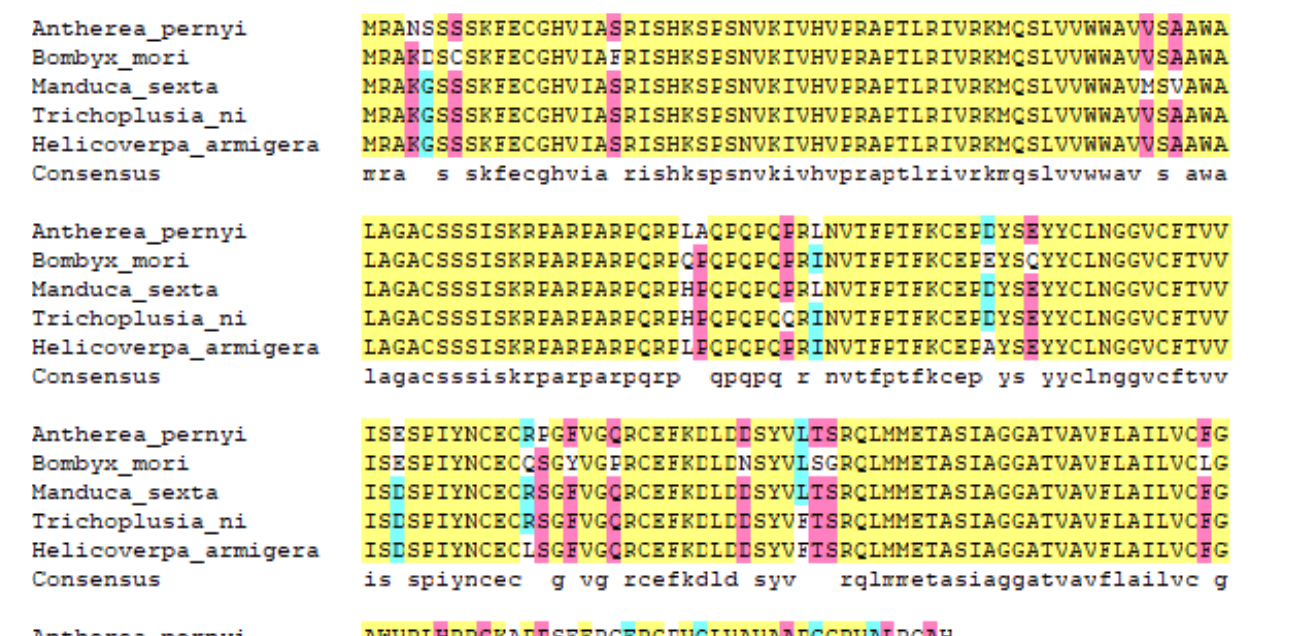
8 of 13 underlined sequence indicates the start codon and stop codon, and light gray indicates the two transmembrane domains. The red arrow pointing to the right ( → ) indicates the forward primer se- quence and pointing to the left ( ← ) indicates the reverse primer sequence.